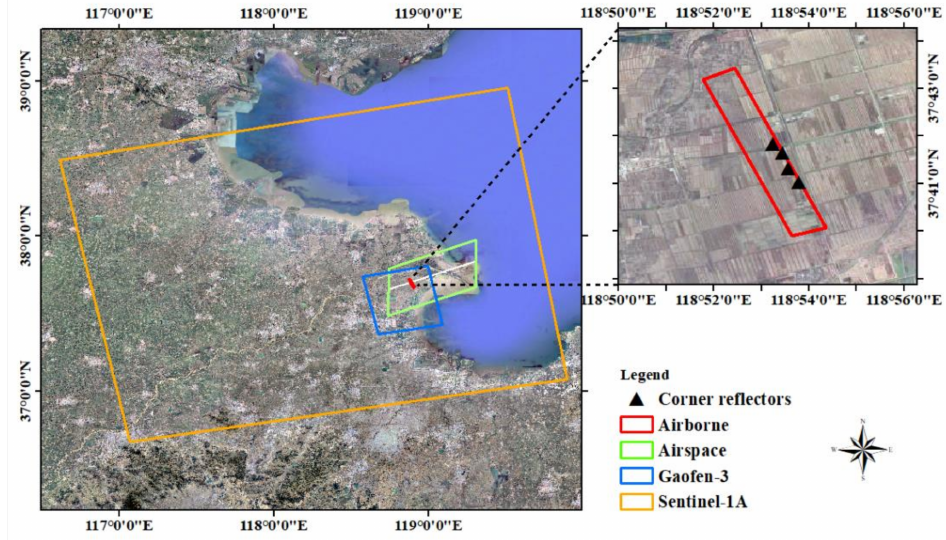
Figure 1. Shandong Dongying comprehensive experimental scope. The orange, blue, and red lines represent the coverage areas of Sentinel-1A, Gaofen 3, and airborne SAR, respectively. The green line indicates the airborne SAR measurement airspace range, and the black triangles represent the corner